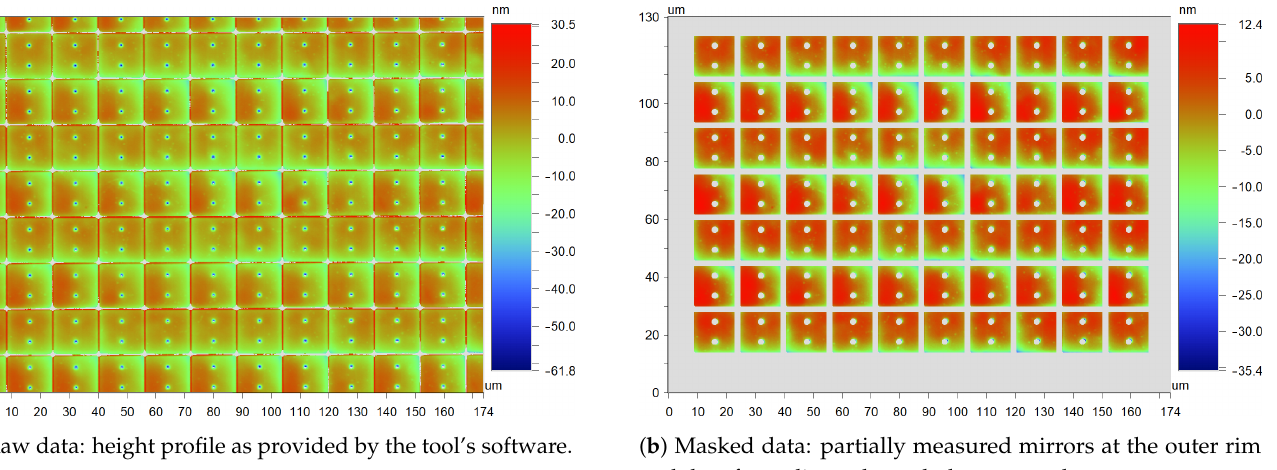
Figure 8. Local flatness measurement by means of an